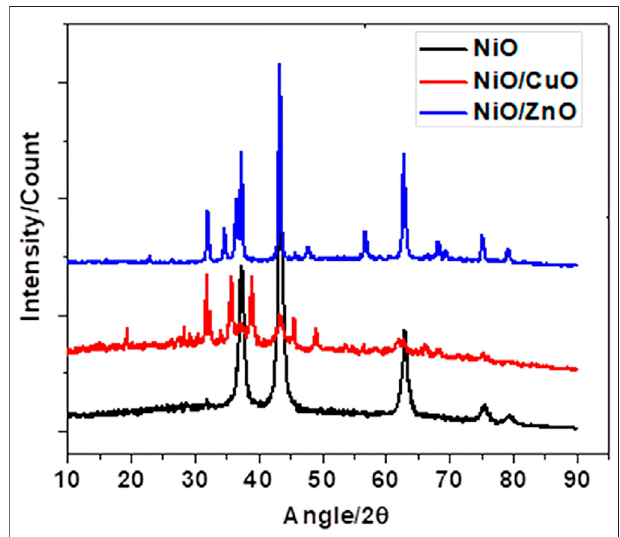
FIGURE 1 | XRD patterns for the NiO, NiO/CuO, and NiO/ZnO nanomaterials prepared with